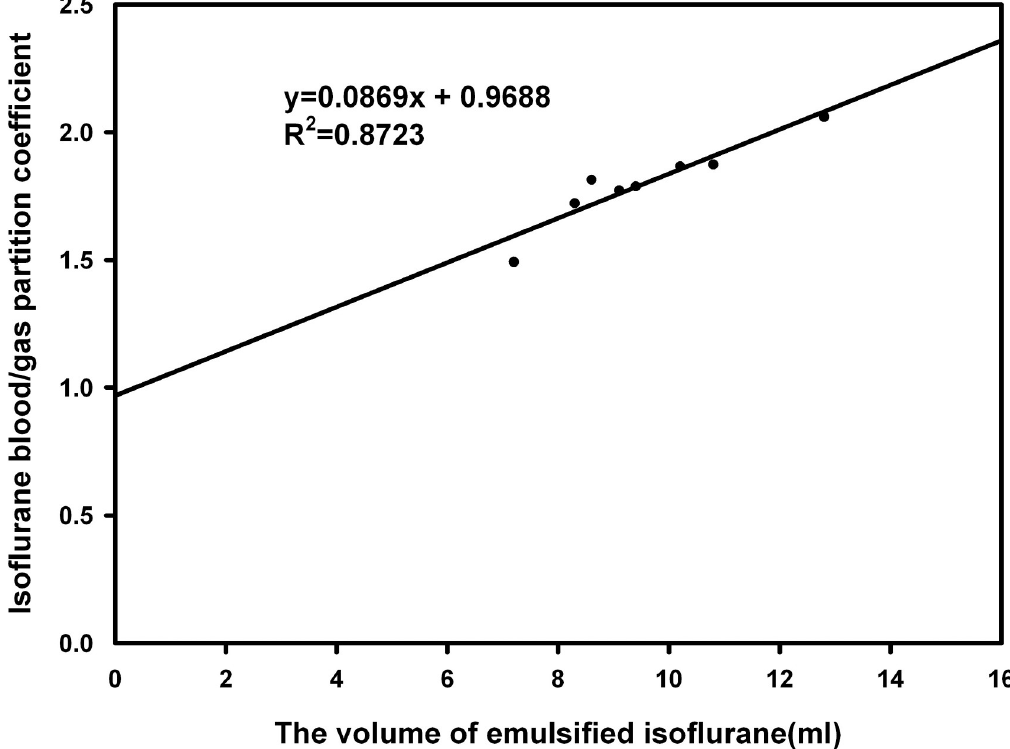
Fig 2. The positive correlation between isoflurane blood/gas partition coefficient and the volume of emulsified isoflurane delivered.